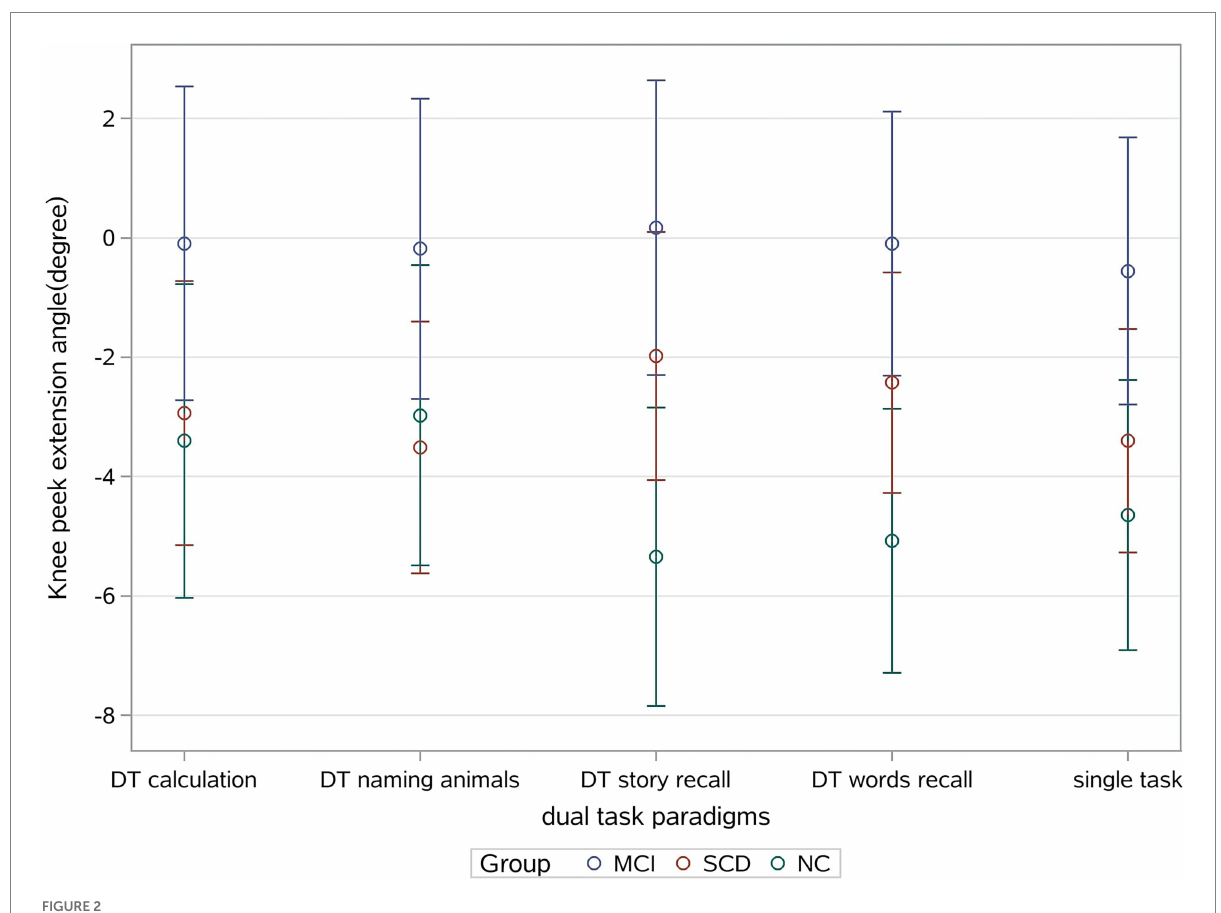
FIGURE 2 Knee peak extension angle and cognitive status of